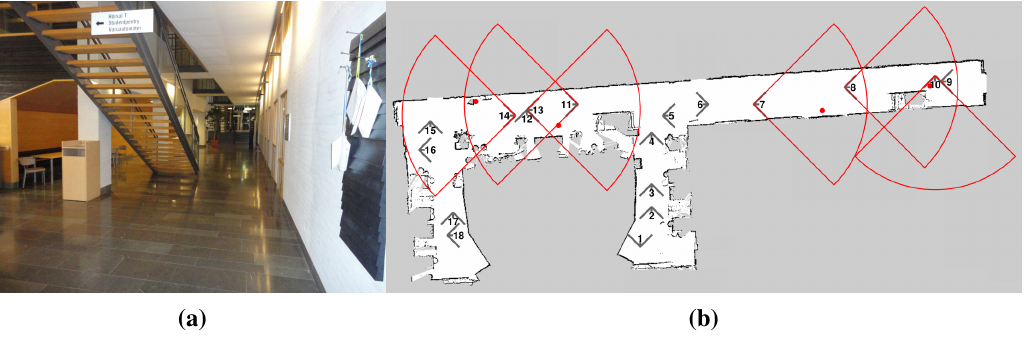
Figure 15. ( a ) an indoor setting for the gas detection task; ( b ) graphical results: the gas sources are indicated by red dots, the planned sensing configuration by truncated cones in gray, and the small number associated to each configuration indicates the order in which they are visited. The configurations plotted in red indicate the positive readings and the actual area they